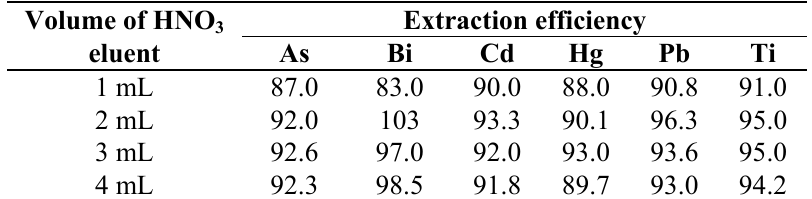
Table 4. The effect of eluent volume on the recoveries of the